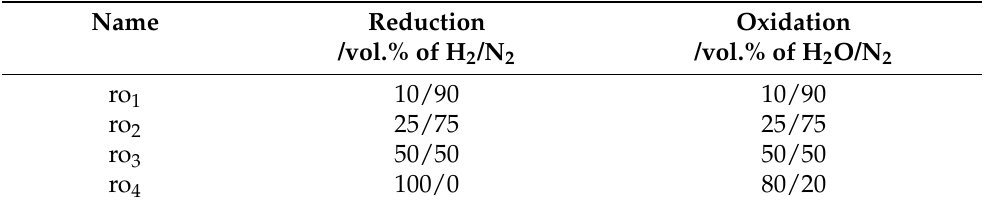
redox experiments ro 1 to ro 4